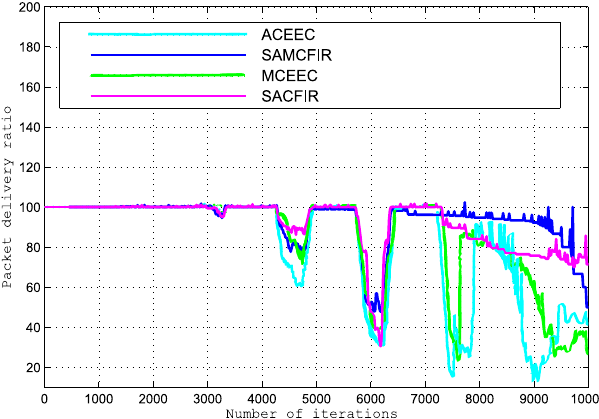
Figure 18. Packet delivery ratio experienced by execution of compared